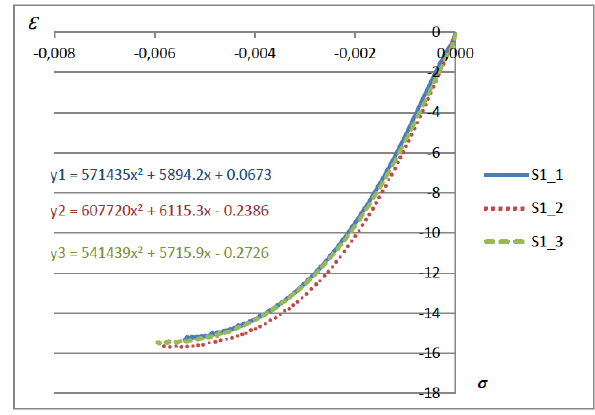
Figure 6: Dependence σ on C2S1 adhesive, three samples under compression